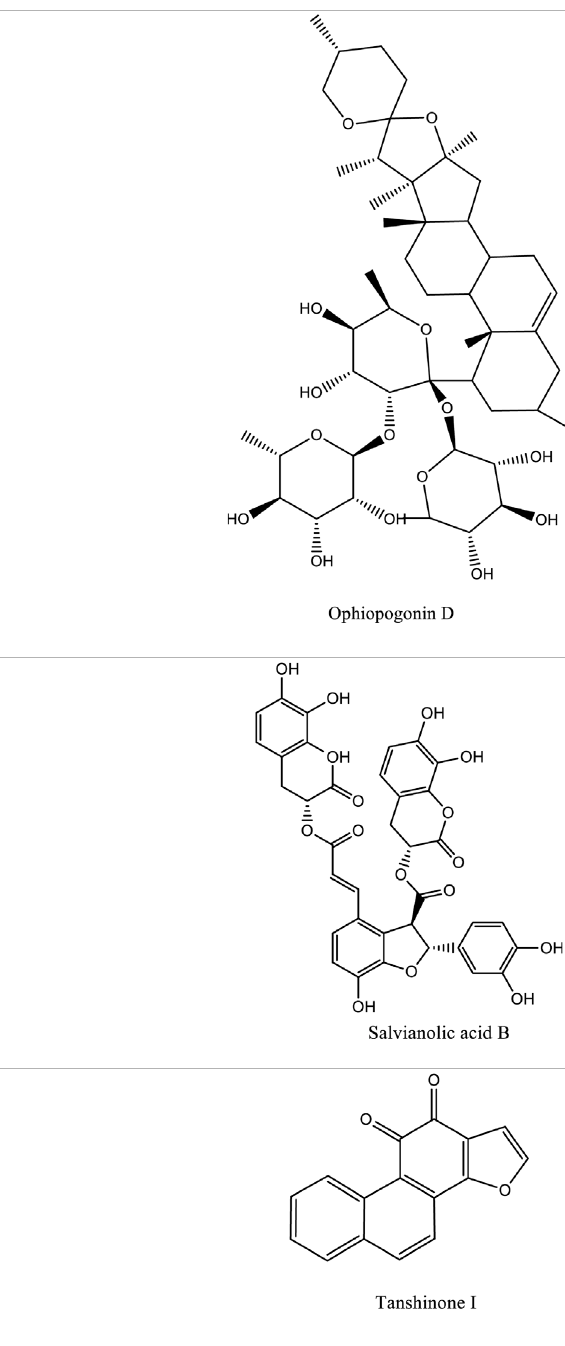
TABLE 3 | Showing chemical structure of the compounds used as